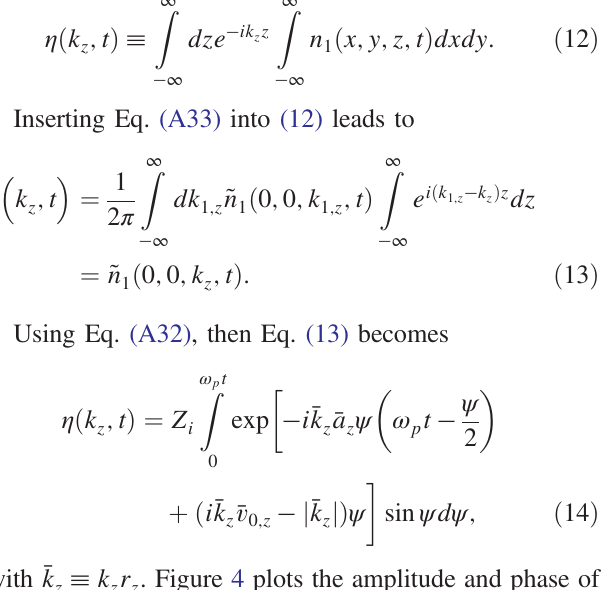
FIG. 4. Fourier components of the modulation in longitudinal density calculated from Eq. (14) for a rest ion and various normalized acceleration parameters. The abscissa is the normalized longitudinal wave number, k ; t Þj =Z The ordinate is j η ð k ; (b) the ordinate is the phase shift of η ð k z i